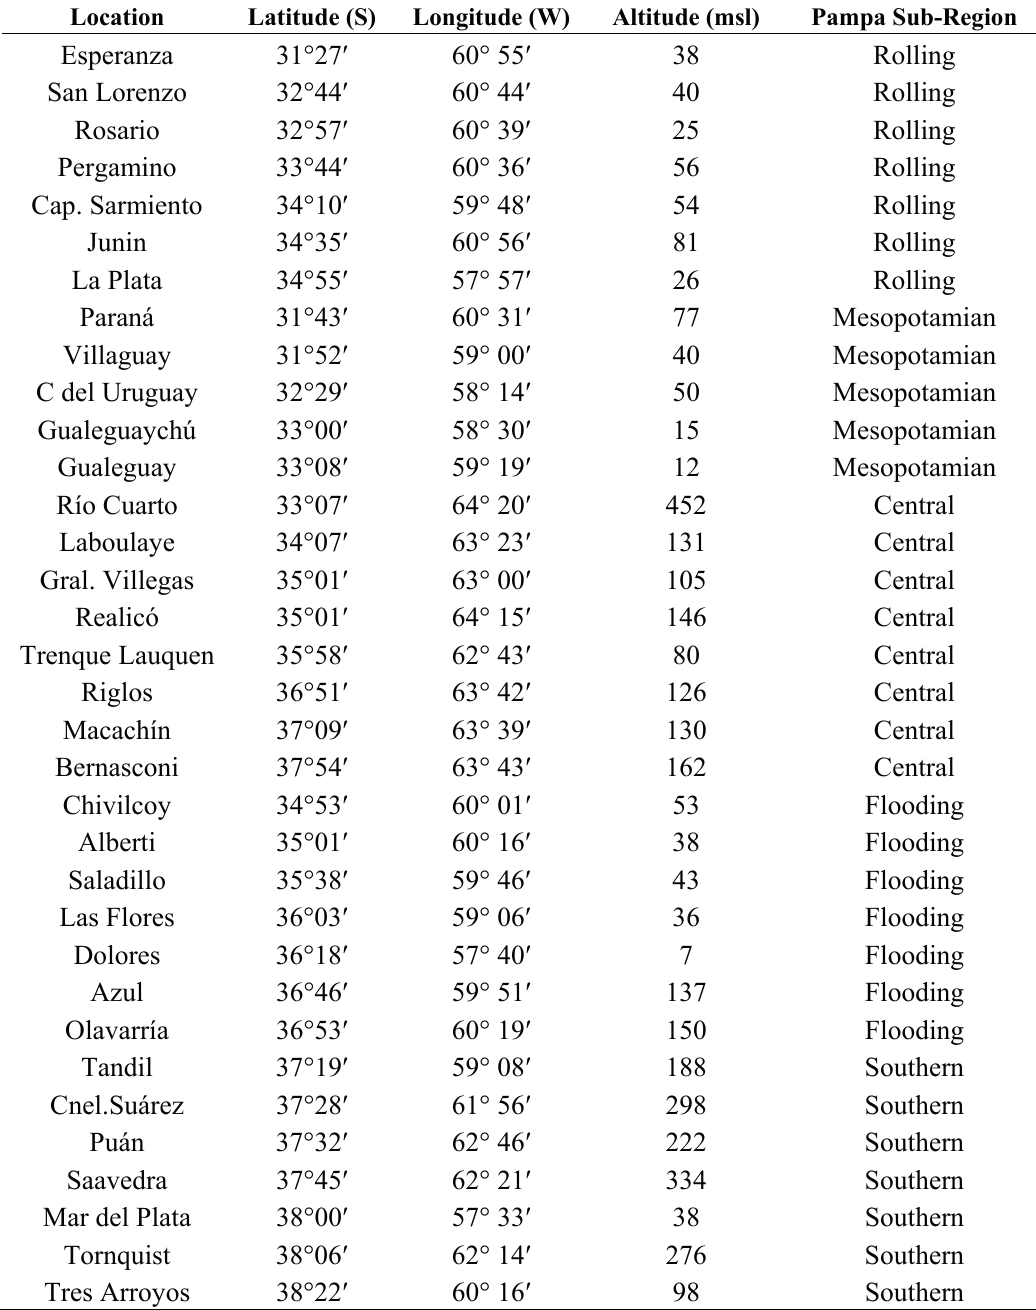
Table 1. Position of the different locations in the Pampa